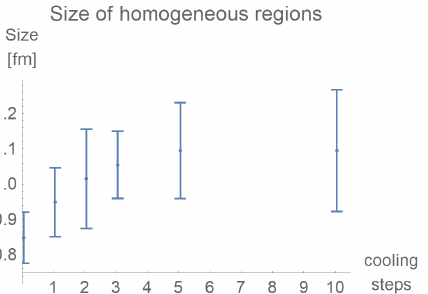
Figure 20. The dependence of the size of homogeneous regions on the number of cooling steps is estimated by combining the data from the lattice sizes 8 4 , 10 4 , respectively smoothing 0, smoothing 1, and smoothing